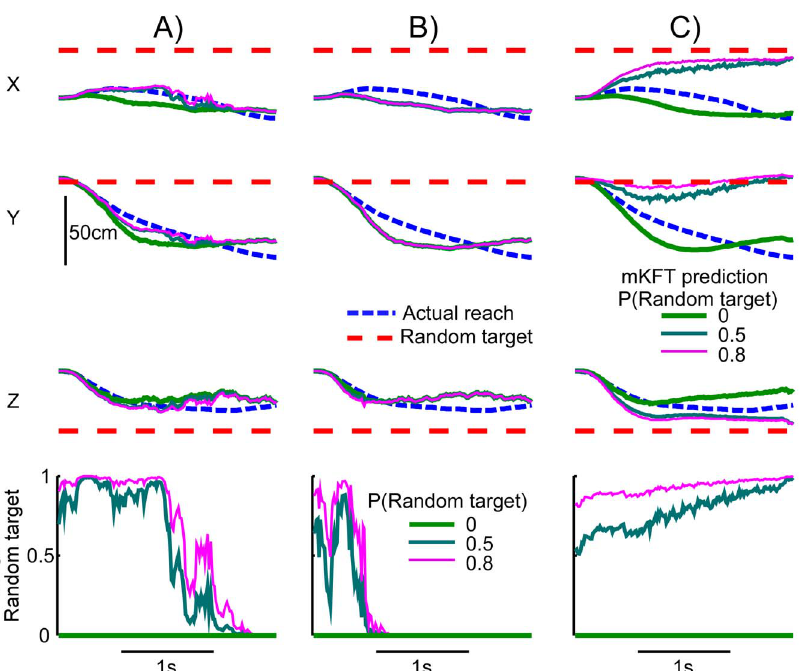
doi:10.1371/journal.pone.0086811.g002